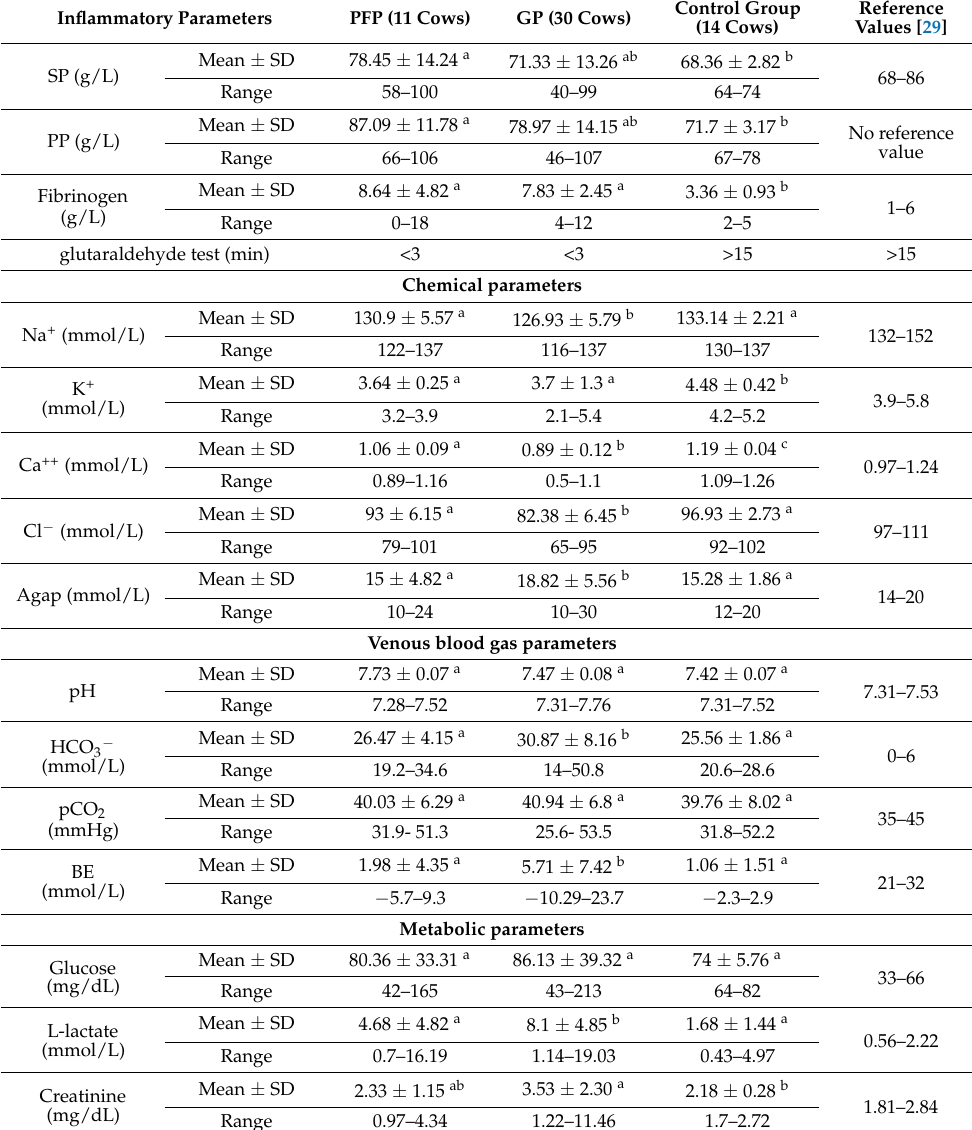
Table 1. Results (mean ± standard deviation and range) and a comparison of the evaluated param- eters (inflammatory, chemical, venous blood gas and metabolic parameters) in cows developing parietal fibrinous peritonitis, cows developing generalised peritonitis and the control group. Inflammatory